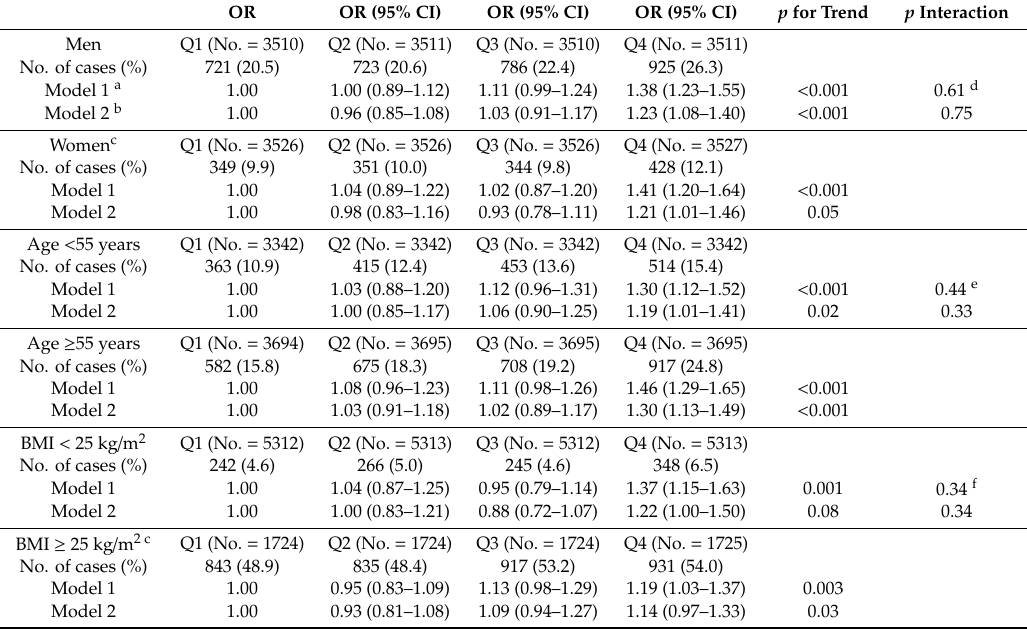
Table 3. Associations of Net Endogenous Acid Production (NEAP) scores with metabolic syndrome according to sex, age and body mass index